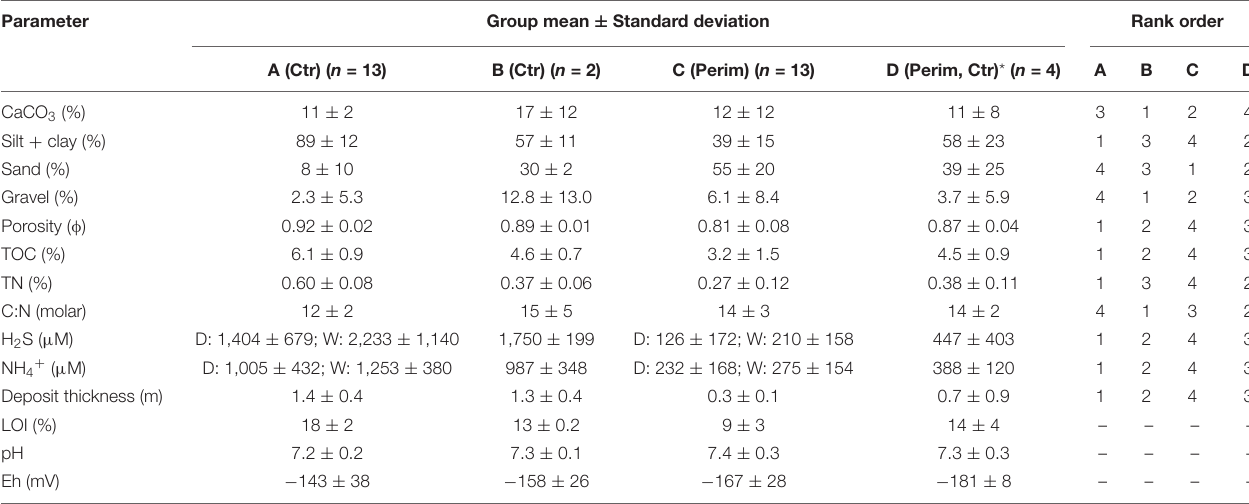
Standard deviation added after SIMPER and for variables without a rank order. Seasonal average for groups A and C recorded for dry (D) and wet (W) when water temperatures near the sediment was 19 ± 3 ◦ C and 29 ± 2 ◦ C, respectively. Groups identified as either center (ctr), perimeter (perim) or both depending on the samples they contained. *3 perimeter, 1